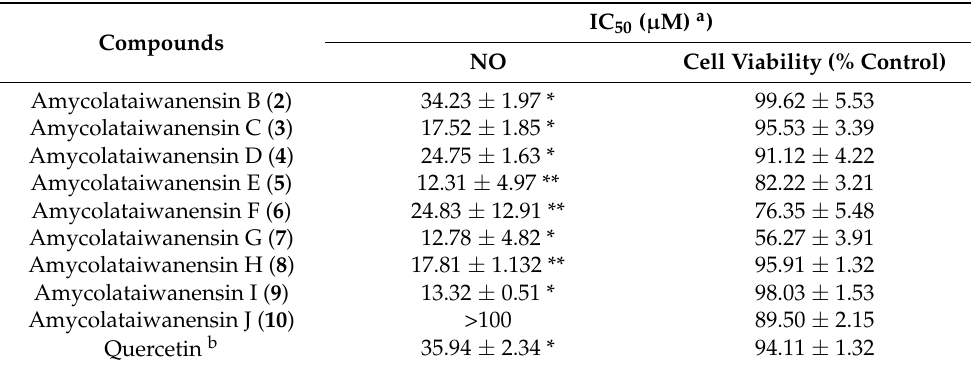
Table 3. Inhibitory Effects of the 9 isolates ( 2 – 10 ) from Amycolatopsis taiwanensis on LPS-activated NO productions in RAW 264.7